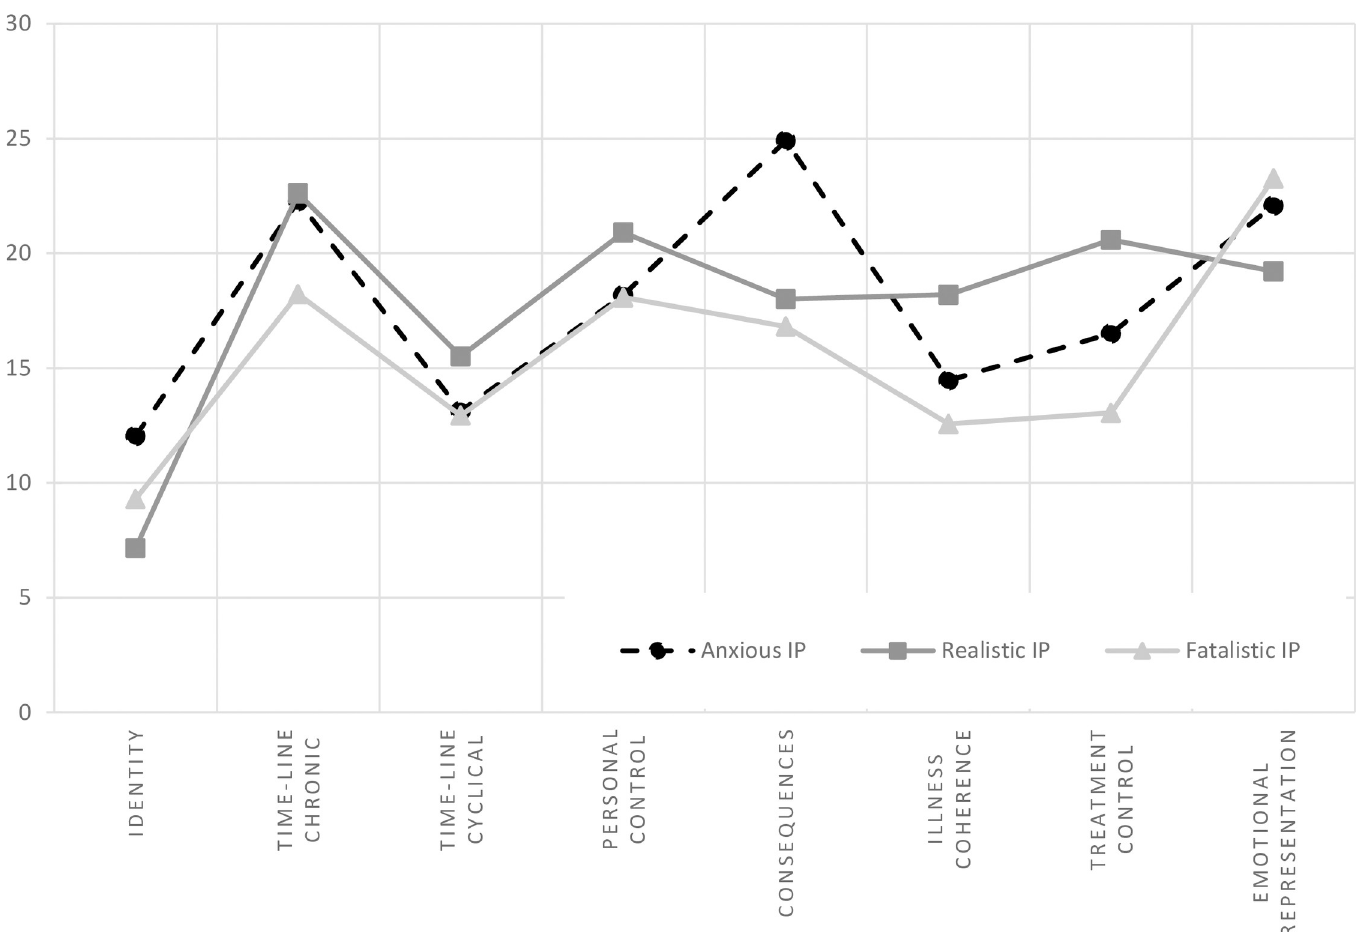
Fig 1. Standard means of clusters distinguished in cluster analysis for illness representation in T1 AIP ( n = 30), RIP ( n = 33) and FIP ( n = 27). https://doi.org/10.1371/journal.pone.0258740.g001 Cluster 2. Realistic Illness Perception (33 patients)–patients in the second cluster presented a realistic illness perception, involving low levels of perceived symptoms and high levels of belief in the cyclical nature of the disease. This group displayed high levels of personal control over MS and higher levels of illness coherence compared to other patients. These patients pre- sented low levels of negative emotions.